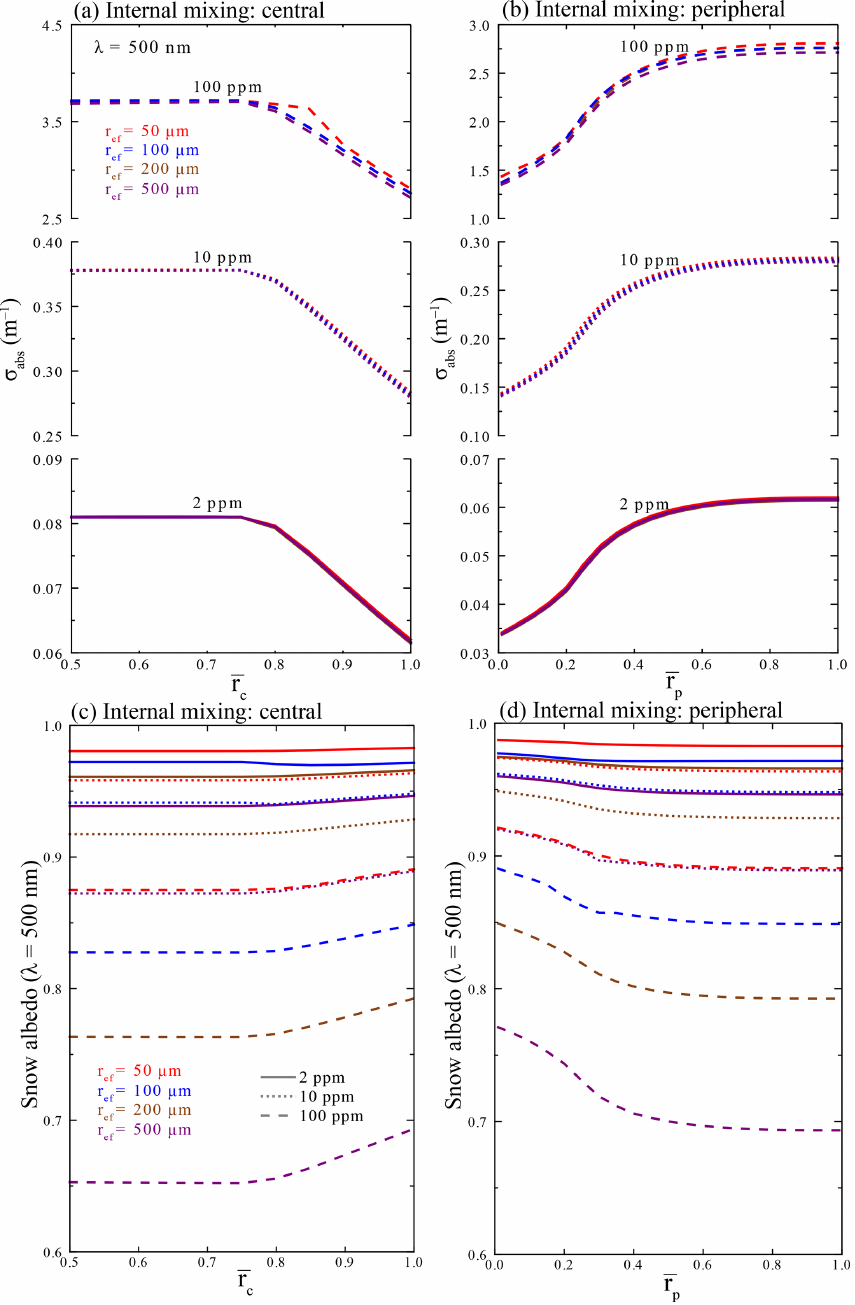
Figure 6. The snow absorption coefficient ( σ abs ) at the 500nm wavelength as a function of r c and r p for (a) internal mixing (central) and (b) internal mixing (peripheral) with different snow grain radii and dust mass concentrations. Panels (c) and (d) are the same as (a) and (b) , but for snow albedo at the 500nm